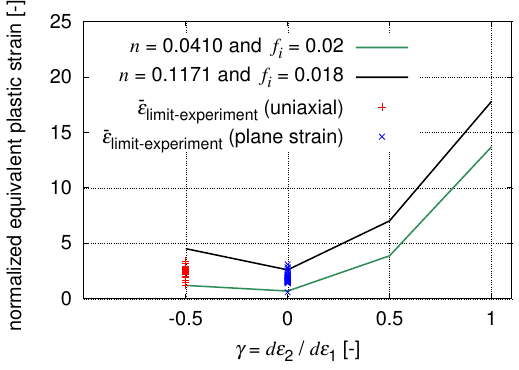
Figure 23. Forming limit band for different loading paths with strains normalized with respect to the mean uniform strain